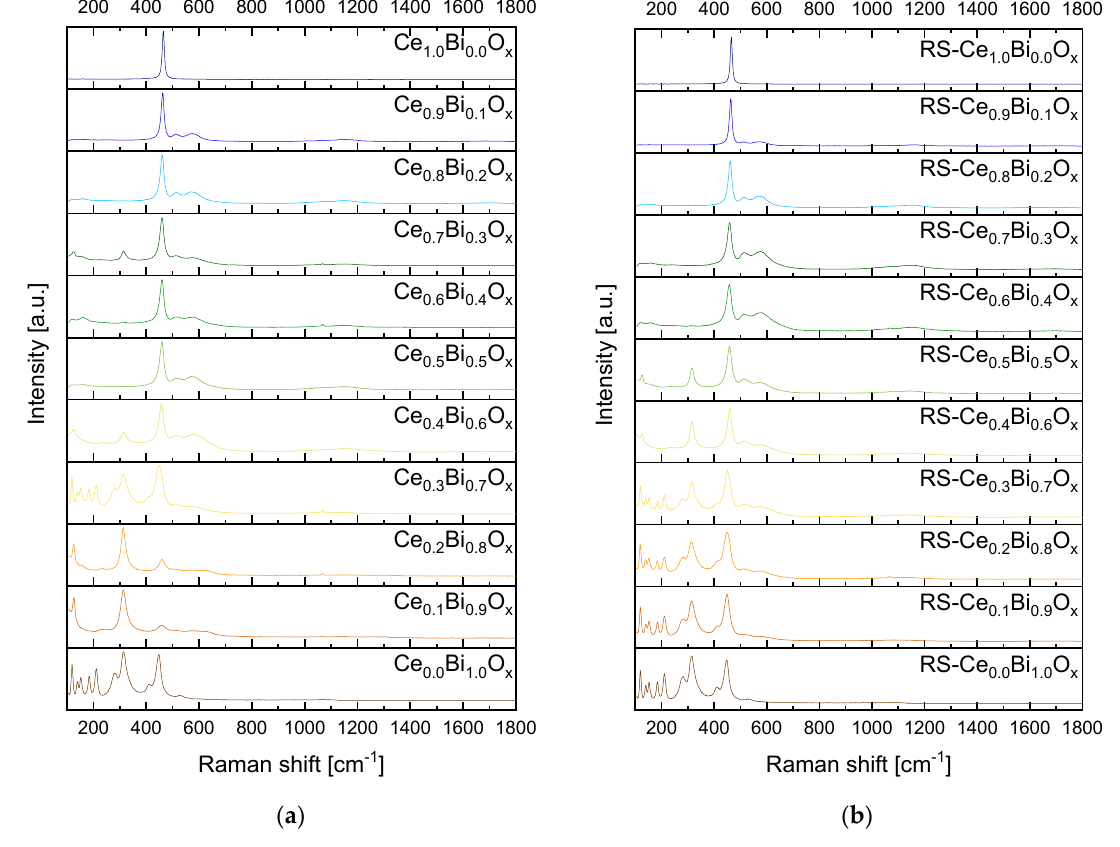
Figure 1. Raman spectra of the synthesized Bi-Ce-mixed oxides with varying Bi-Ce-molar ratios in 10 mol% steps. Each sample is measured three times. Shown are representative spectra of these measurements. All spectra are normalized for comparison. Oxides have been calcined at T = 800 °C. Laser wavelength is λ = 532 nm. ( a ) Normal synthesis route; ( b ) Reverse strike synthesis route.